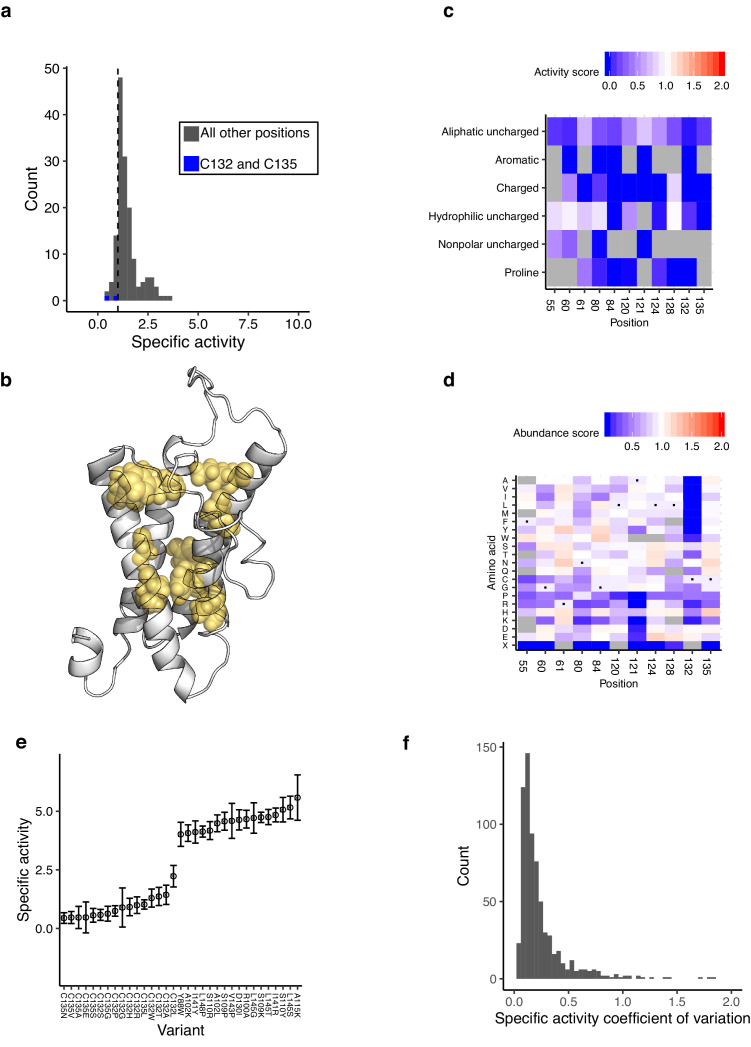
VKOR active site analysis.(a) Histogram of specific activity, with catalytic cysteines C132 and C135 labeled in blue. Dashed line demarcates bottom 12.5%. (b) Active site positions as defined by computational docking, shown on the homology model as yellow spheres (Czogalla et al., 2017). (c) Heatmap of activity scores for residues with lowest 12.5% of specific activity scores, collapsed by amino acid class. Color indicates activity scores scaled as a gradient between the lowest 10% of activity scores (blue), the WT activity score (white) and activity scores above WT (red). Grey indicates missing data. (d) Heatmap of abundance scores for residues with lowest 12.5% of specific activity scores. Color legend same as described in c, applied to abundance scores. (e) Specific activity scores of a subset of variants, with error bars showing standard deviation. (f) Histogram of coefficient of variation for the specific activity value.